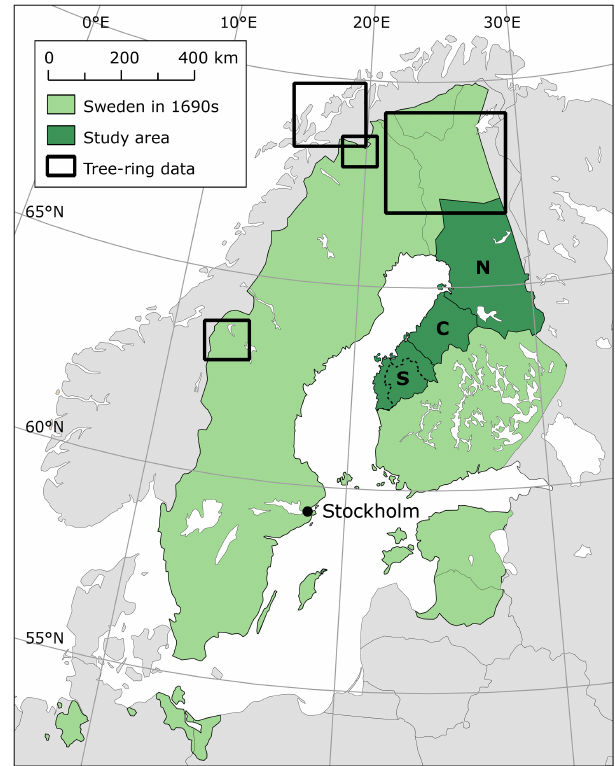
Figure 1. Study area, the approximate tree-ring data sample sites for the temperature reconstruction used in this study, and the sub- regions (northern, central, and three southern regions; see Table 1) referenced in the